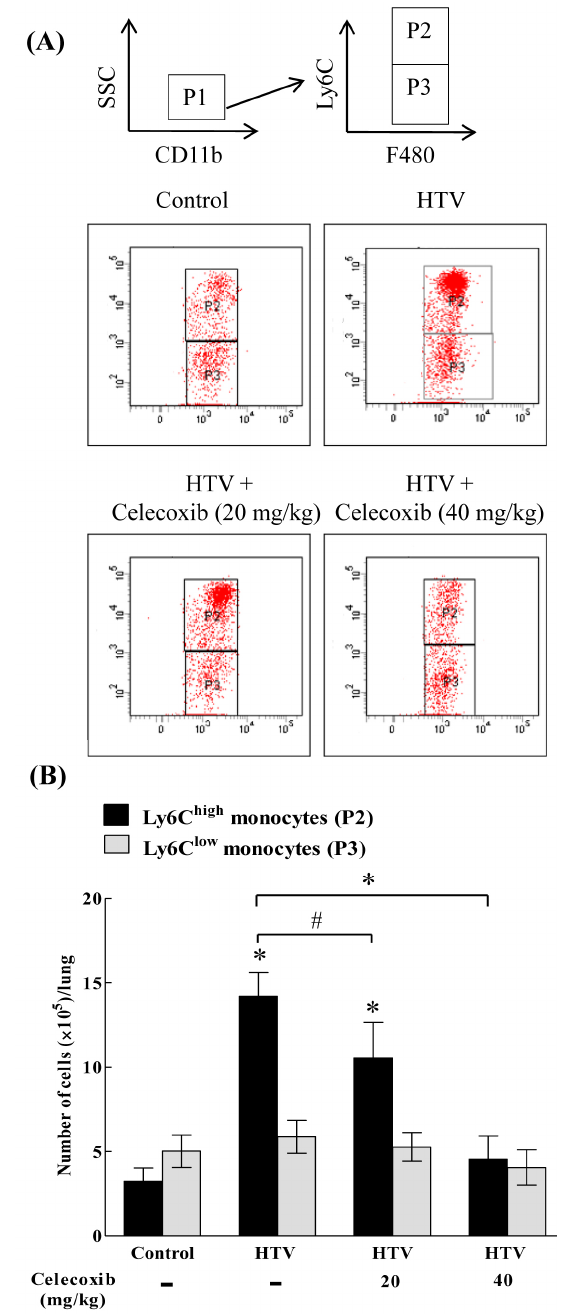
Figure 3. Celecoxib significantly diminished the recruitment of Ly6C high , but not Ly6C low , monocytes in VILI. ( A ) Gating strategy of flow cytometry analysis. ( B ) The numbers of Ly6C monocytes in lung homogenates. Values represent the mean ± SD ( n = 6). # p < 0.05 and * p < 0.01, when compared with the control or between groups.